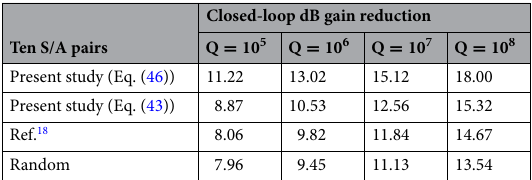
Closed-loop dB gain reduction